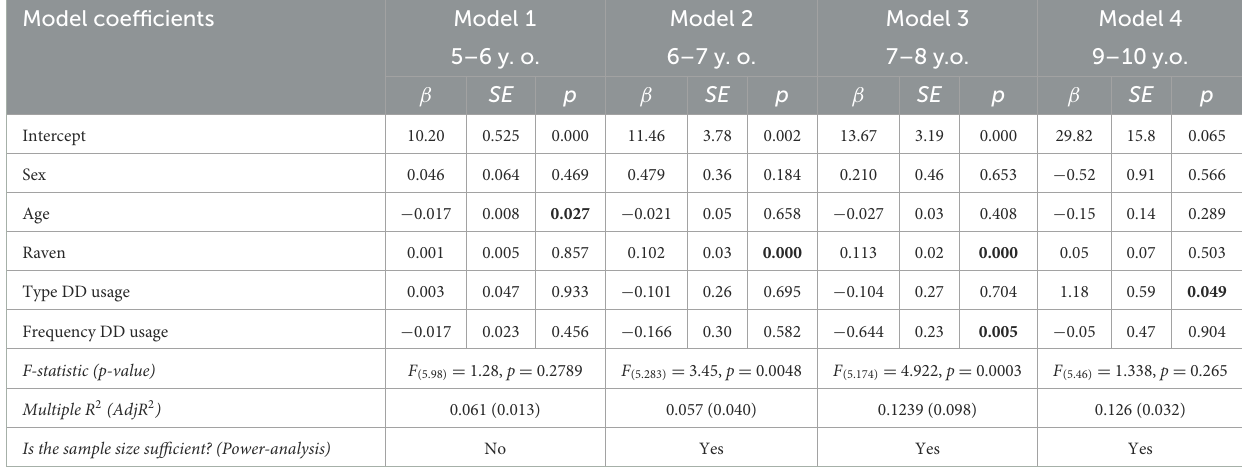
TABLE 5 Multiple linear regression analysis for the study variables predicting inhibition from the senior kindergarten group to third school grade.